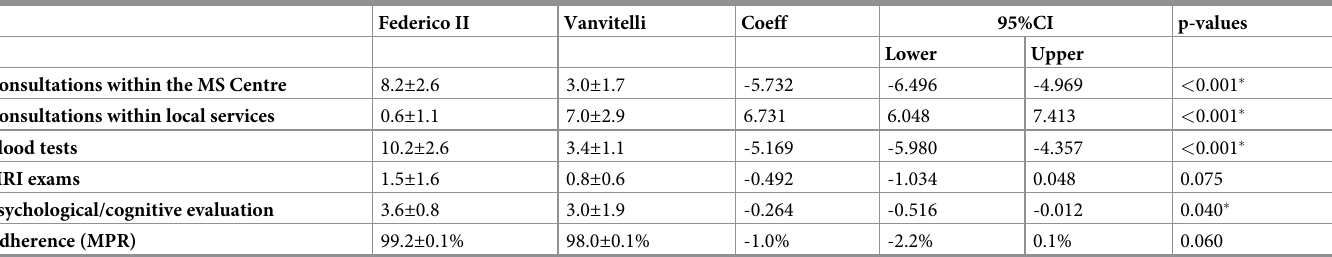
Table 3. Healthcare resource utilization and adherence.